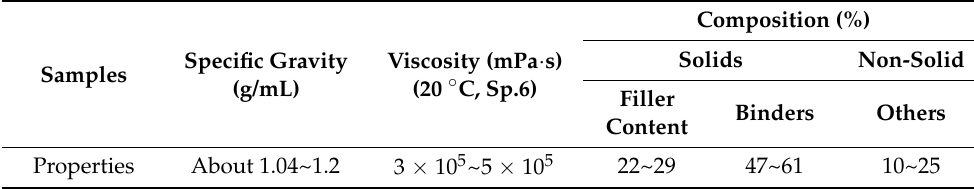
Table 1. General Properties of BEM.